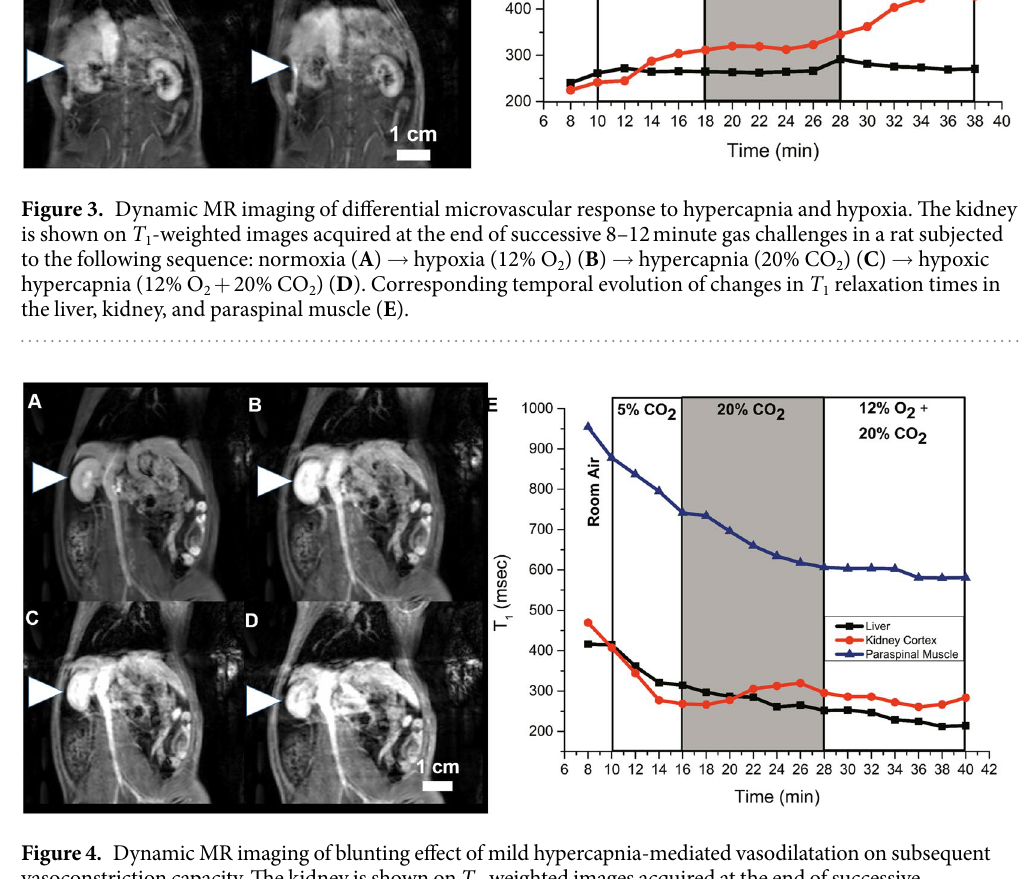
A sample real-time perfusion recording obtained from laser Doppler measurements is shown in Fig. 8 for both the kidney cortex and the liver. The decrease in perfusion observed on transition to 20% CO 2 and further decrease on transition to hypercapnic hypoxia, is analogous to similar signal decreases on MRI (see Fig. 2). Likewise, mild increases in perfusion on the transition to 5% CO 2 correlates with increased signal on MRI. These gold-standard perfusion measurements support the interpretation of increasing and decreasing signal intensity as indicators of vasodilatation and vasoconstriction, respectively.